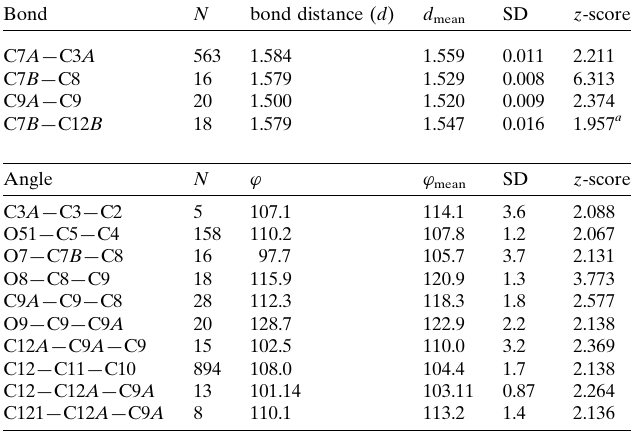
Table 1 Unusual bond distances and bond angles ( ’ ) (A˚ , (cid:3) ) extracted from Mogul . z -score = | d (cid:4) d mean |/SD, where d mean and SD are the mean and standard deviation of N observed values in the Mogul database. The z -score for bond angles is calculated replacing d by ’ . A bond distance or angle is considered unusual if the z -score > 2.